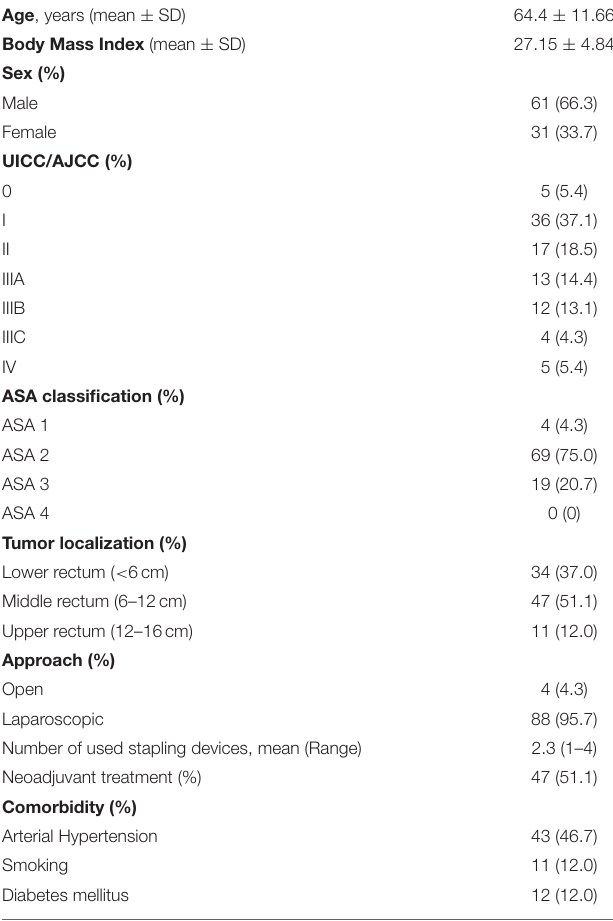
TABLE 2 | Characteristics of the study cohort ( n = 92).